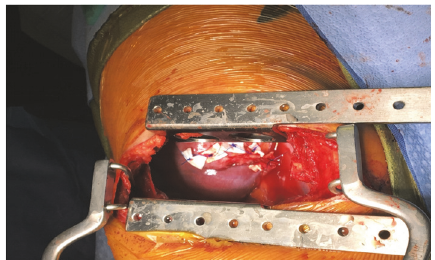
Figure 4: Suture repair of the diaphragmatic defect.